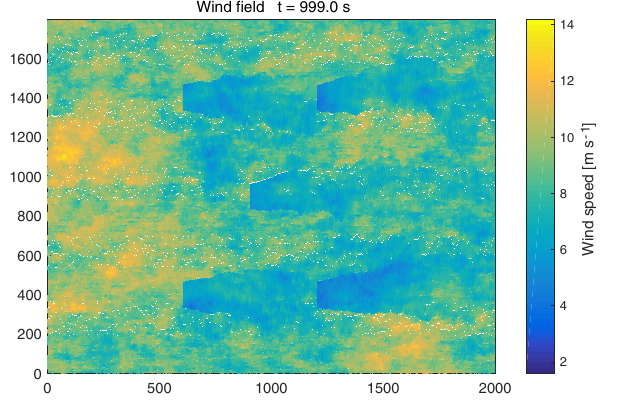
Figure 8. Snapshot of the wind field and wake